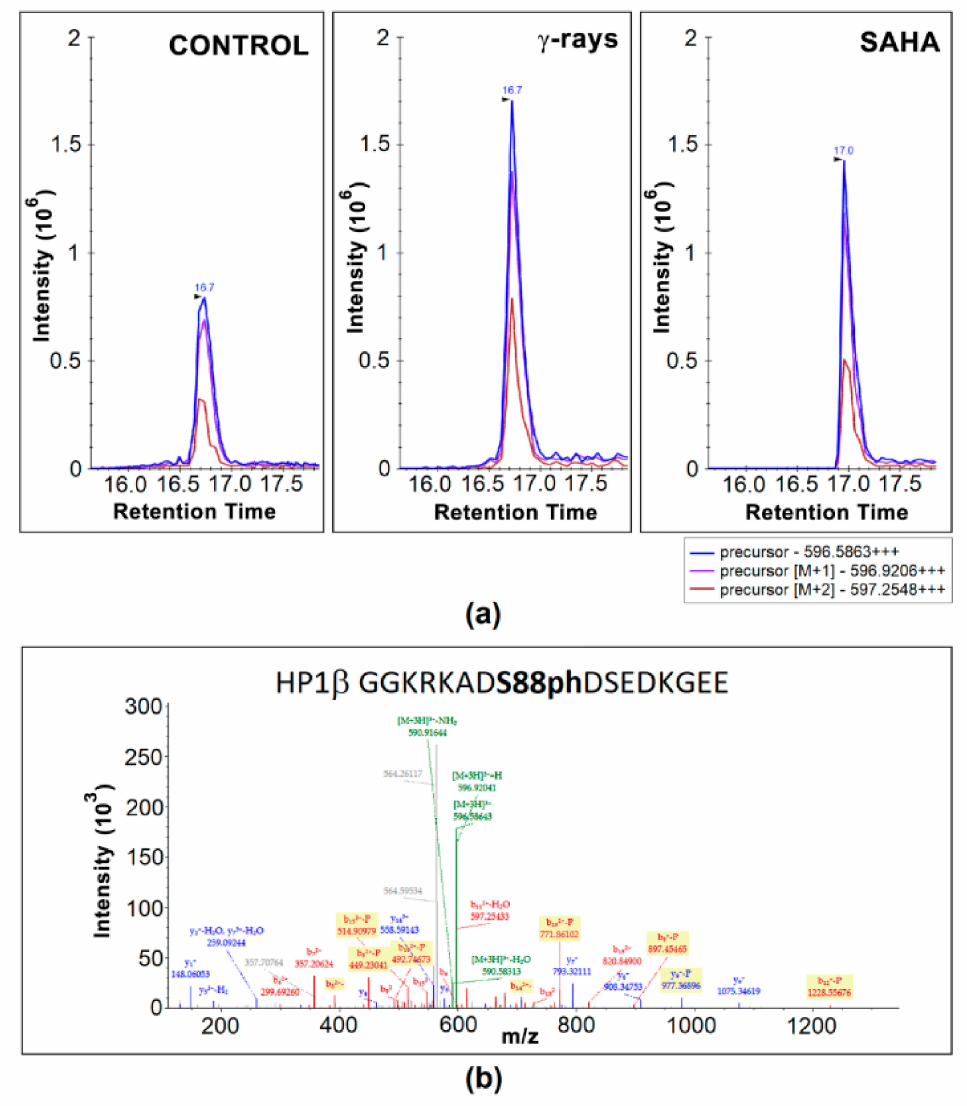
Figure 5. Representative MS and MS / MS spectra of HP1 G81 − E96 peptide carrying phosphorylation at S88 ( m / z 596.586). ( a ) MS extracted ion chromatograms of the 3 + charged HP1 β -S88ph peptide precursor showing changes in its abundance after γ -irradiation (5 Gy) and SAHA (15 µ M) treatment. The three colored lines correspond to the ion chromatogram of the monoisotopic peptide mass and the first two isotopes. ( b ) MS / MS spectrum produced from the precursor ion of m / z 596.586. The deposition of the mass spectrometry proteomics data see at the ProteomeXchange Consortium (for detailed information, see Methodology